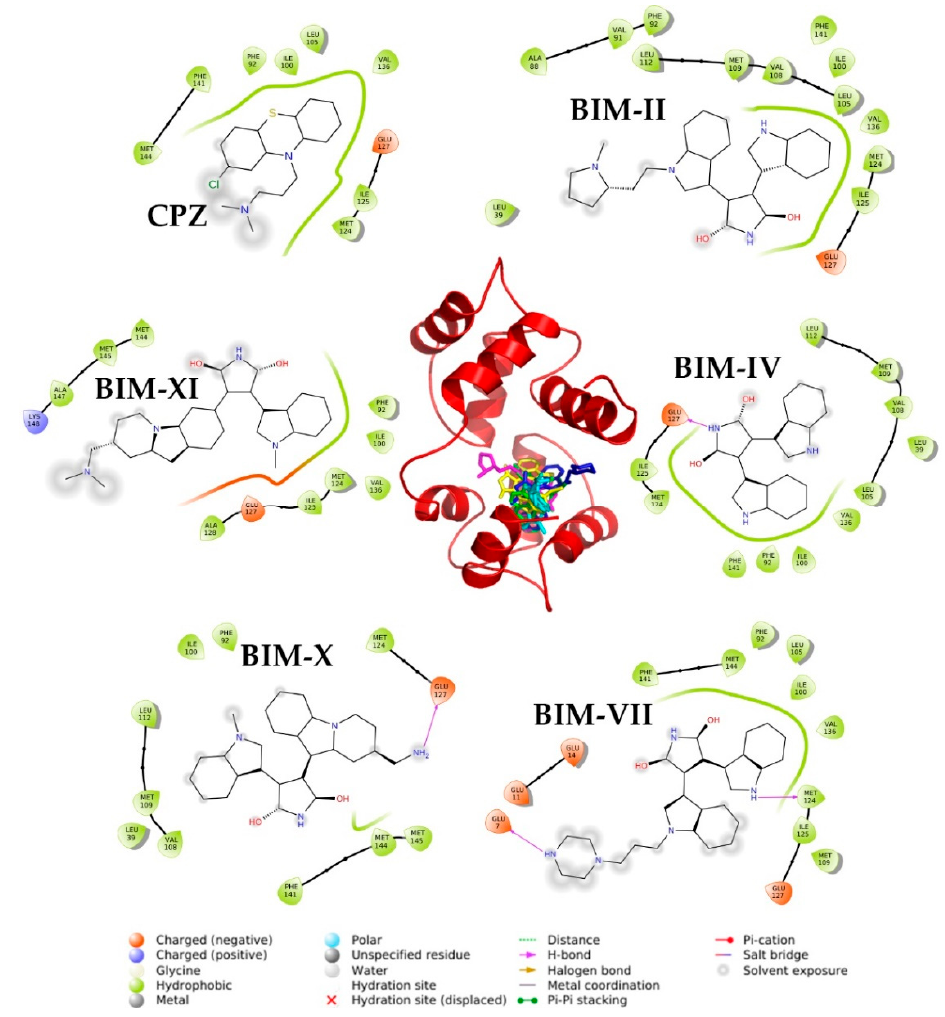
Figure 6. Structural model of docking results with BIMs compounds in site I of the CaM. The interactions with the residues at 4 Å are shown in the periphery. The image was made with PyMOL and Maestro. Table 2. Interactions of BIM compounds with CaM from the site I docking.